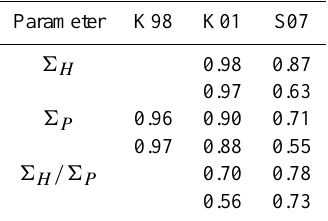
Table 1. Pearson correlation coefficients between the conductance parameter estimates from EISCAT and from the three methods un- der test. The upper number in each case is for Case 1, the lower number is for Case